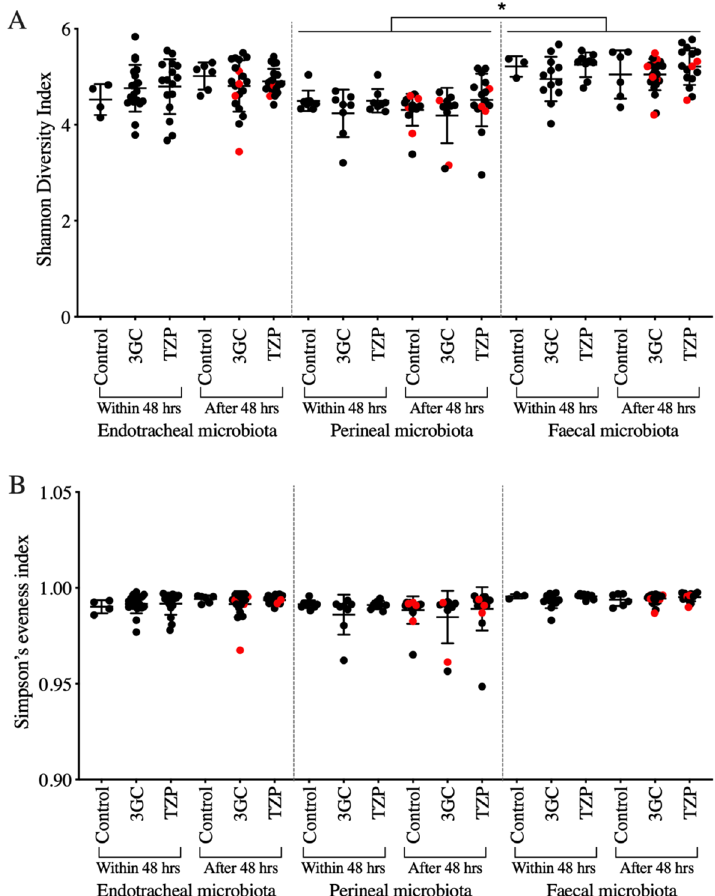
Figure 1. Alpha diversity of microbial communities of the 3GC, TZP and control groups presented as ( A ) Shannon diversity and ( B ) Simpson’s evenness indices, (3GC-third-generation cephalosporins, TZP- piperacillin/tazobactam, control-no β-lactams). Both alpha diversity indices were determined using microbial abundance at the OTU level. Data are shown as mean ± standard deviation. Dots represent individual samples for endotracheal, faecal and perineal microbiota of each patient. Samples collected within and after 48 h of antibiotic administration (3GC and TZP groups) or ICU admission (control group) are shown. Diversity indices of microbiota samples collected between day 6 and 11 are shown in red. Significance was determined by Tukey’s multiple comparison tests with Geisser-Greenhouse correction (* P < 0.05) using GraphPad Prism (version 9, GraphPad Software, USA, www. graph pad. com). Detailed information on sample size per treatment group are provided in Supplementary Table